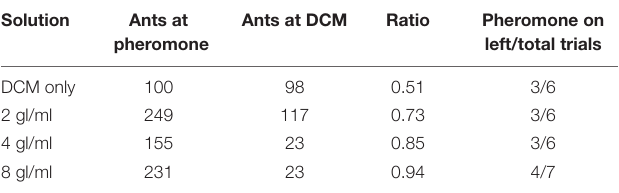
enumerator. We then ran a linear mixed model (LMM)